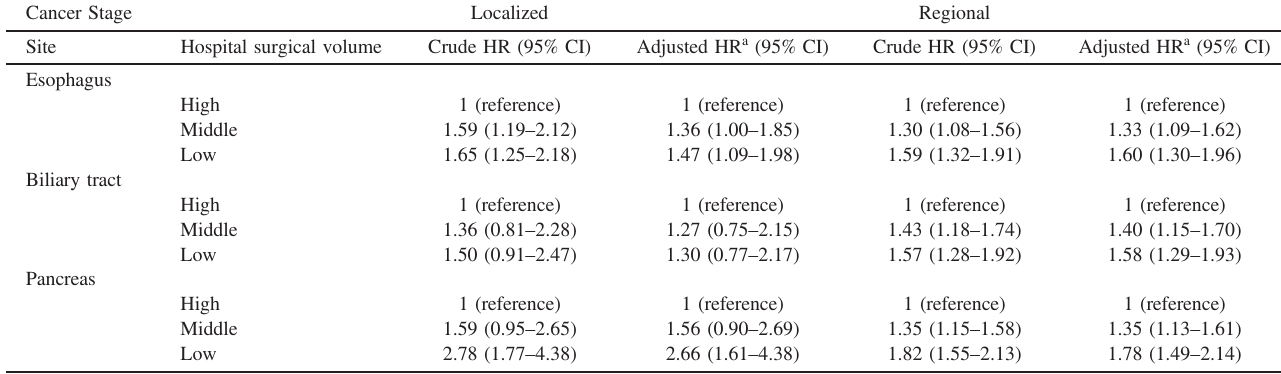
Table 5. Association between hospital surgical volume and 3-year mortality in esophageal, biliary tract, and pancreatic cancer patients who received curative surgery, with and without adjustment for patient characteristics, classifying by cancer stage Cancer Stage